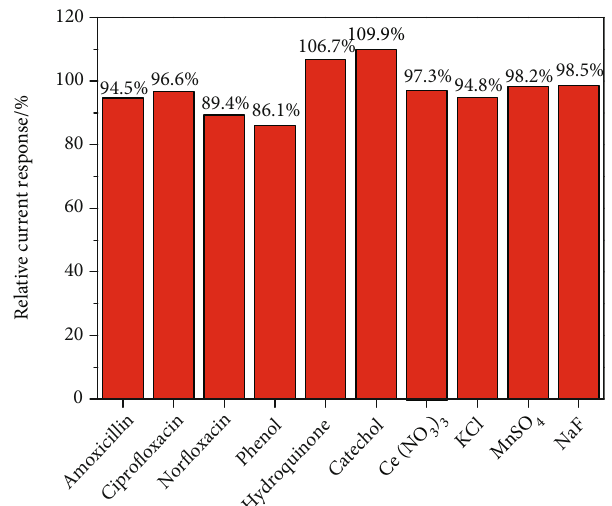
Figure 6: Amperometric response of MIL-53 (Fe)/GCE to tetracycline (1.278 μ mol/L) coexistent with di ff erent interfering substances (other antibiotics interferences with 10 times concentration (12.78 μ mol/L): amoxicillin, cipro fl oxacin, and nor fl oxacin. Typical organic interferences with 100 times concentration (127.8 μ mol/L): phenol, hydroquinone, and catechol. Typical inorganic interferences with 100 times concentration (127.8 μ mol/L): Ce 3+ , NO 3- , K + , Cl - , Mn 2+ , Na + , and F - ). It was pair system that one interference coexistent with tetracycline in one test, and the DPV responses of the sensor to tetracycline were recorded. Other conditions were the same as described elsewhere. The DPV response of the sensor to bare tetracycline was set as the value of